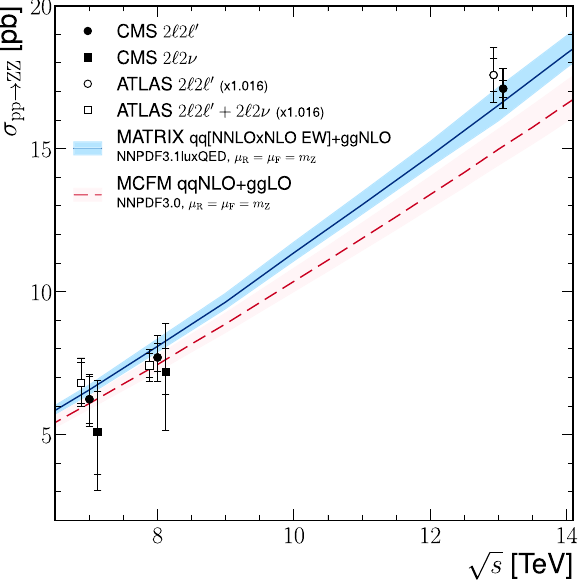
Fig. 3 The total ZZ cross section as a function of the proton–proton center-of-mass energy. Results from the CMS [4,5] and ATLAS [9,10, 14] experiments are compared to predictions from Matrix at NNLO in QCD and NLO in EW, and mcfm at NLO in QCD. The mcfm predic- tion also includes gluon-gluon initiated production at LO in QCD. The predictions use NNPDF31_nnlo_as_0118_luxqed and NNPDF3.0 PDF sets, respectively, and fixed factorization and renormalization scales μ = μ = m F R Z . Details of the calculations and uncertainties are given in the text. The ATLAS measurements were performed with a Z boson mass window of 66–116GeV, instead of 60–120GeV used by CMS, and are corrected for the resulting 1.6% difference in acceptance. Mea- surements at the same center-of-mass energy are shifted slightly along the horizontal axis for clarity